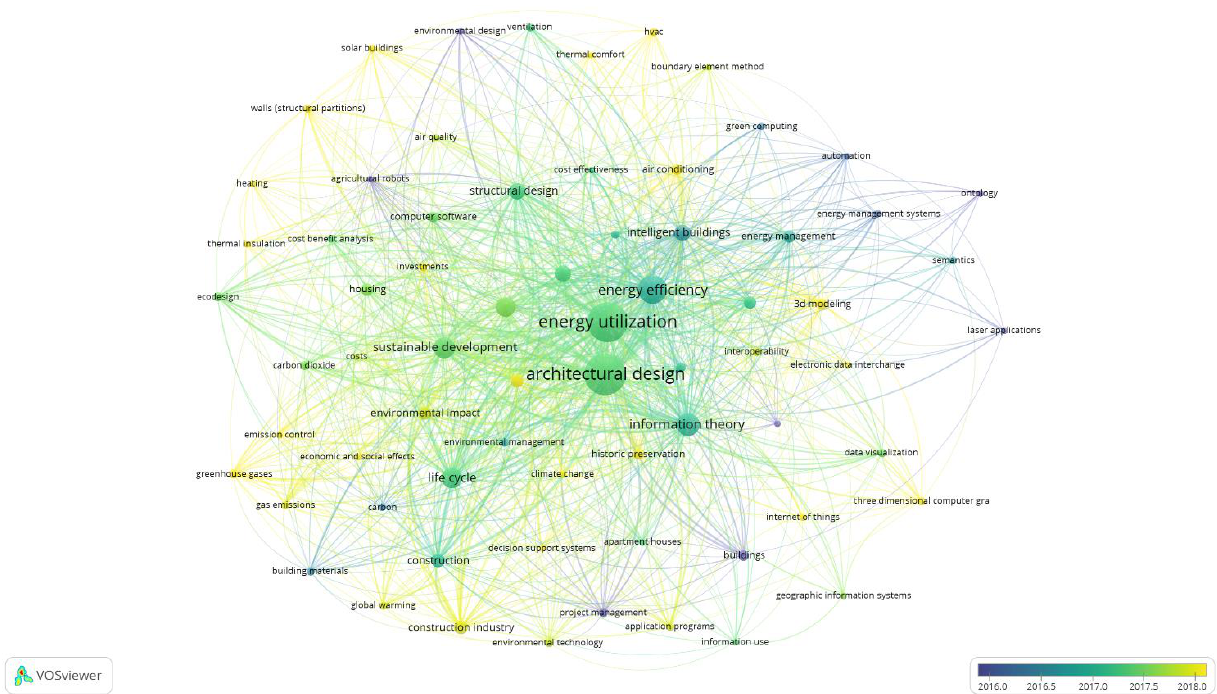
Figure 8. Keyword co-occurrence analysis. Table 6. High-frequency keywords (frequency > 10). Sequence Number